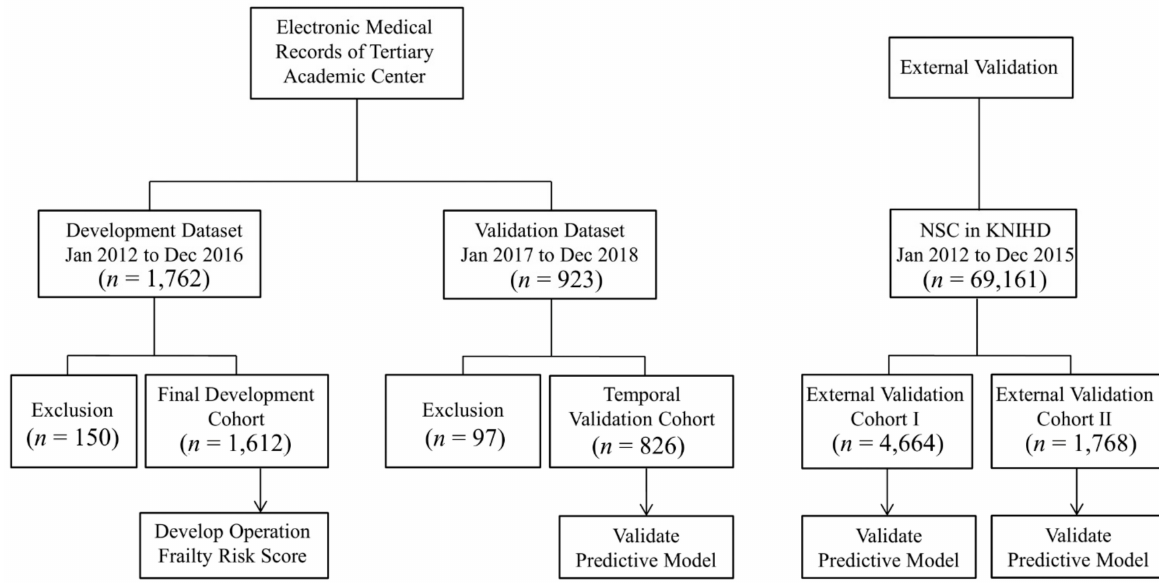
Figure 1. Diagram of the study dataset analysis. Four cohort datasets for the development and validation of predictive models. NSC, Normal Sample Cohort; KNHID, Korean National Health Insurance